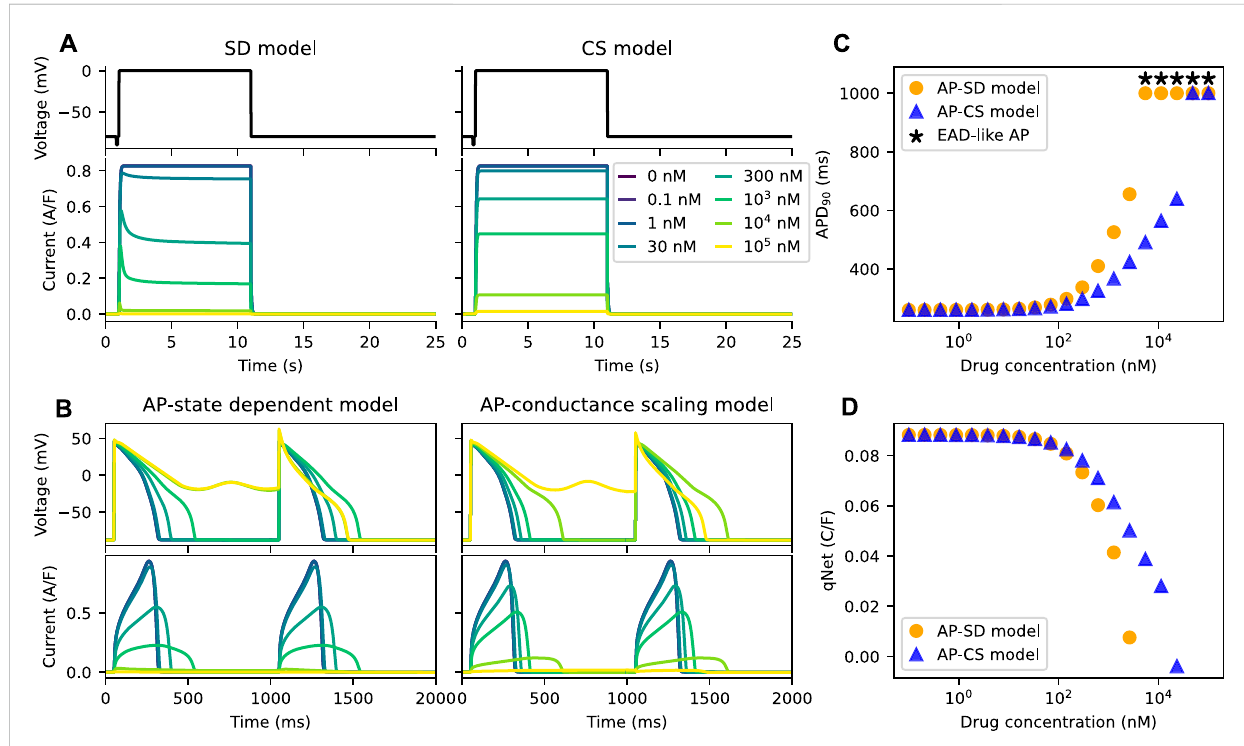
FIGURE 4 The AP-CS model is less successful at replicating the model behaviour of the AP-SD model for an example drug N. (A) The comparison of the I Kr simulated by both the SD model and the CS model after calibration of the hERG ionic conductance for an example drug N. The top row shows Milnes ’ protocol usedtostimulatethehERGchannelmodels. (B) TheAP ( fi rst row)anditshERGcurrent(secondrow) fortheAP-SDmodel andtheAP-CSmodel at steady state. (C) The APD 90 s of the AP-SD model and theAP-CSmodel under the effect of an example drug N. APs that show EAD-like behaviour are indicated with an asterisk. (D) The qNetvaluesof theAP-SD model and theAP-CS model underthe effect ofexample drug N. qNetvaluesofAPs with EAD-like behaviours are not